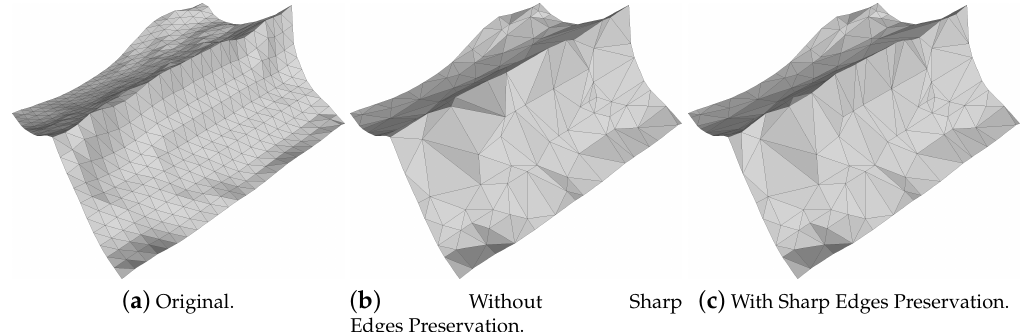
Figure 5. The effect of preserving and not preserving sharp edges in the terrain when using point set simplification methods. In this case, we used the simple random point set deletion method. Applying this method directly without detecting sharp edges, as shown in ( b ), results in the main crest of the original image being destroyed. On the contrary, by applying our method, the polyline corresponding to the crest is identified, and while it is also simplified, the shape closely resembles that of the original data, as shown in ( c